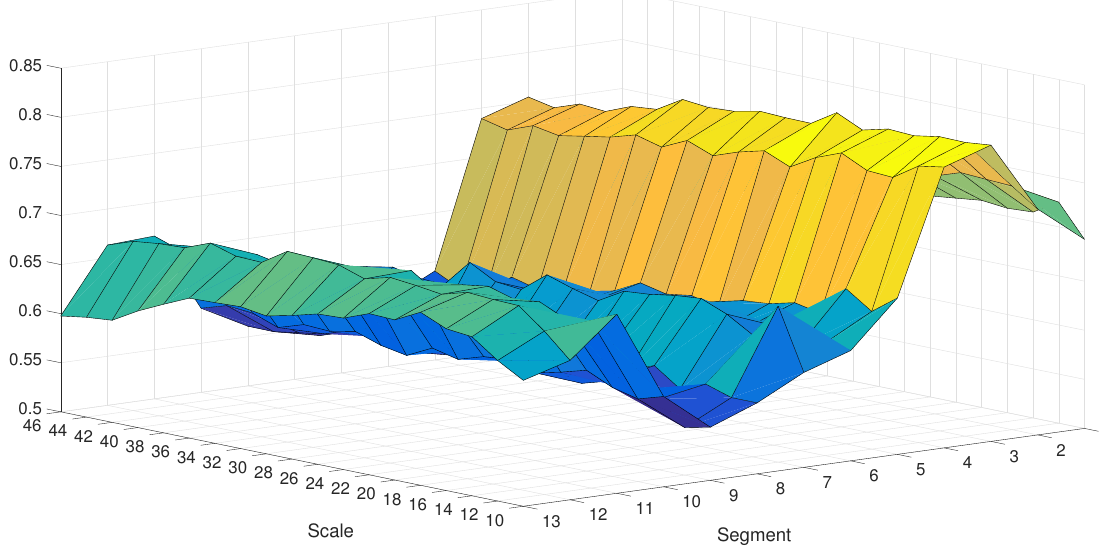
Figure 4. Accuracy for different values of segment Id and the scale factor